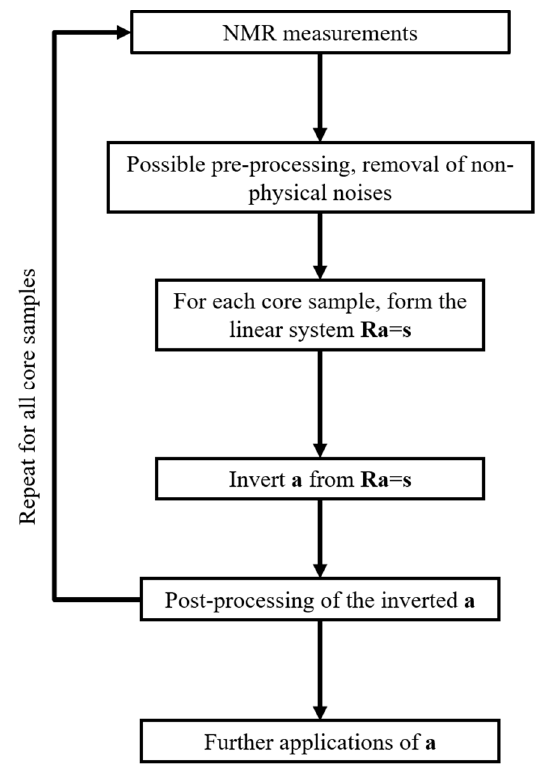
Figure 6. Workflow of NMR inversion.